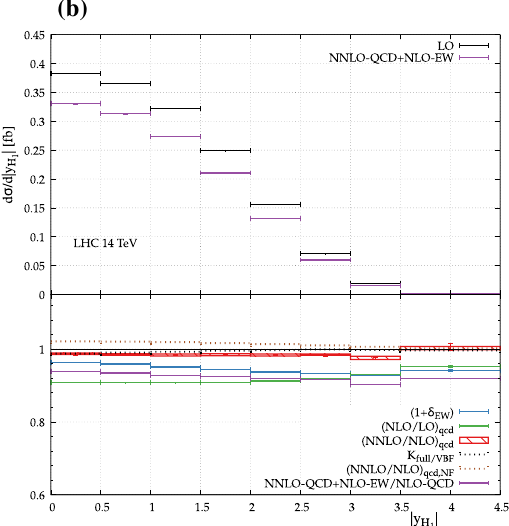
Fig. 3 Differential distributions for pp → jjHH at the LHC with centre-of-mass energy of 14 TeV: a rapidity of the hardest jet (left) and b rapidity of the hardest Higgs boson (right). The upper panel shows the